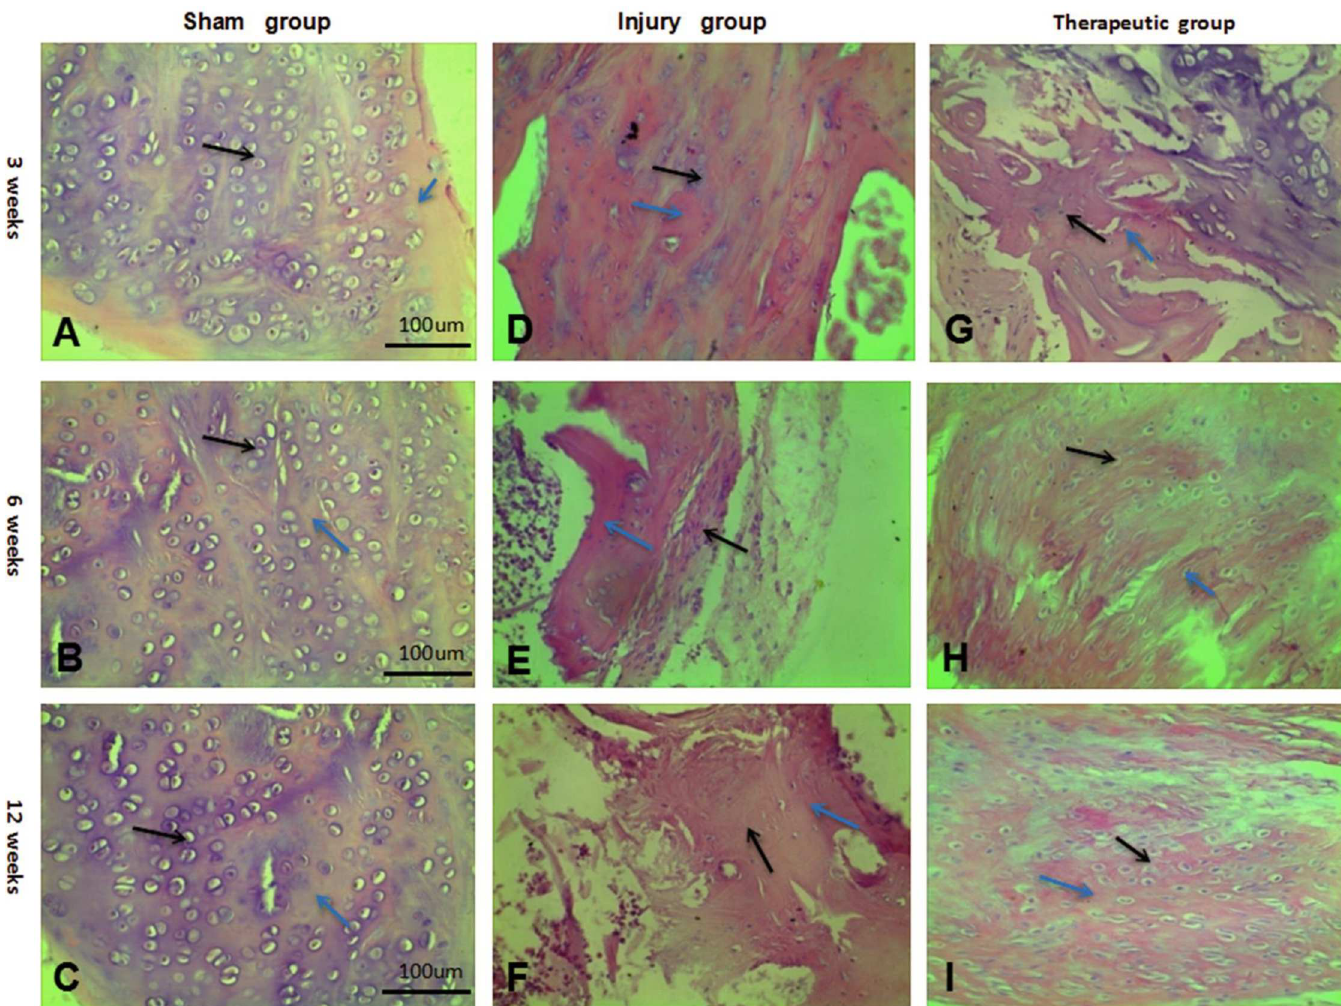
Fig 3. Results of HE staining in each group after 3,6,12 weeks. (A-C) HE staining in the sharm group after 3,6,12 weeks ( × 100). (D-F) HE stainingin the injury group after 3,6,12 weeks ( × 100).(G-I) HE stainingin the therapeuticgroupafter3,6,12 weeks ( × 100).Bluearrows:collagen and matrix.Black arrows: